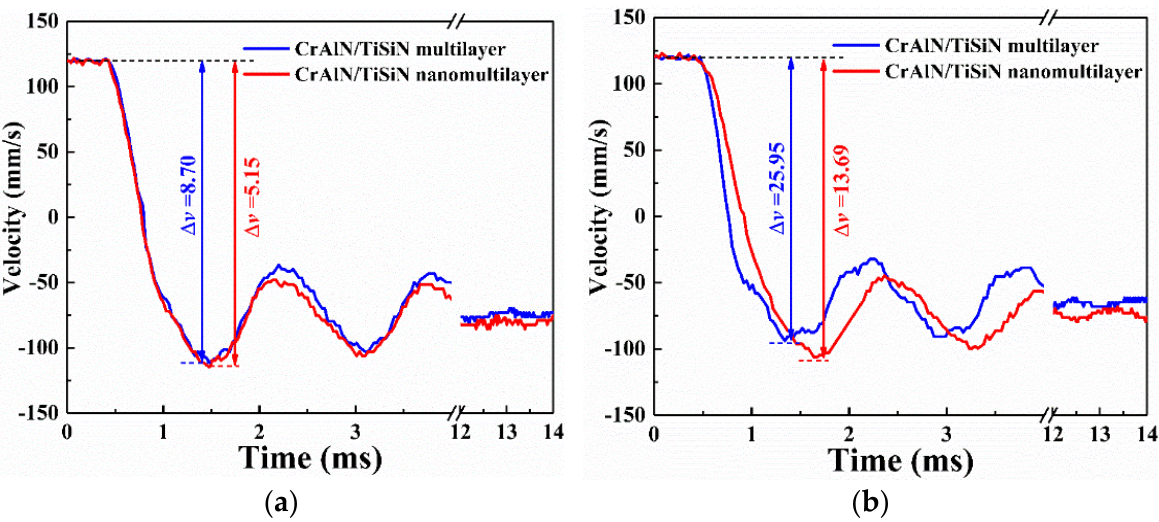
Figure 7. Impact velocity response of two CrAlN/TiSiN coatings at 10 4 cycles. ( a ) No sand; ( b ) Sand.